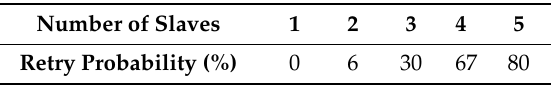
Table 5. Retry probability per number of slaves.